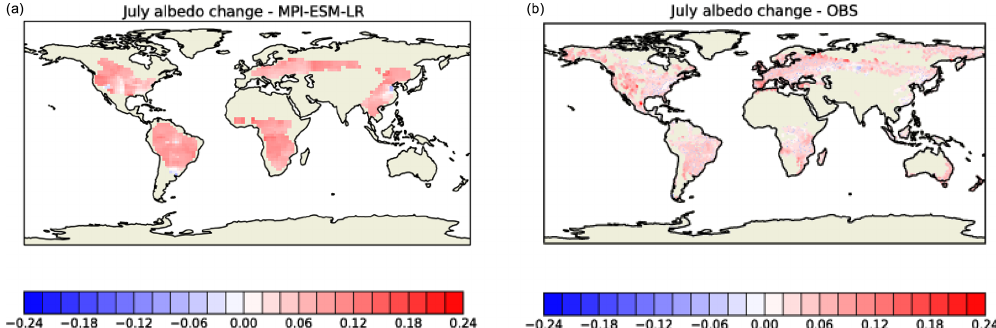
Figure 34. Potential albedo change due to a transition from land cover type “tree” to “crops and grasses” calculated through a multiple linear regression between the present-day land cover fractions (predictors) and albedo (predictands) within a moving window encompassing 5 ◦ × 5 ◦ grid cells. Results are shown for (a) the MPI-ESM-LR model (2001–2005 July mean) and (b) the observational dataset from Duveiller et al. (2018a) (2008–2012 July mean). Produced with recipe_landcoveralbedo.yml ; see details in Sect. 3.4.2 and in Lejeune et al. (2020).